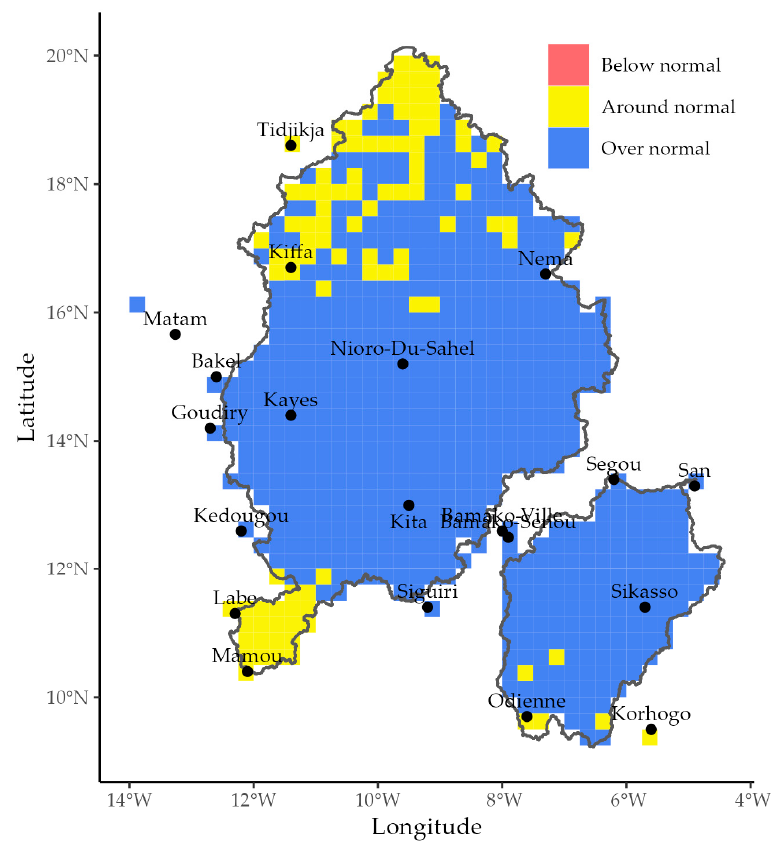
Figure 7. Classification of the seasonal rainfall forecast for 2021 over the Bani River and Senegal River watersheds in terms of wet, normal, and dry.